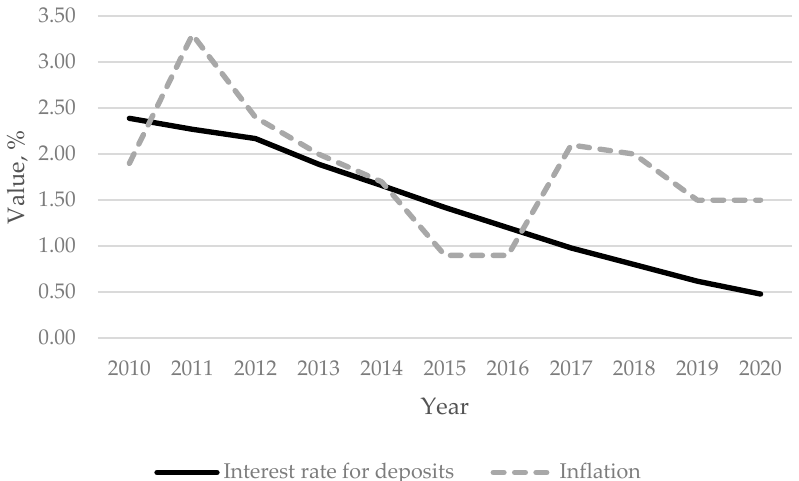
Figure 6. Development of bank deposit interest rates and inflation 2010–2020 (own illustration based on [56,57]).